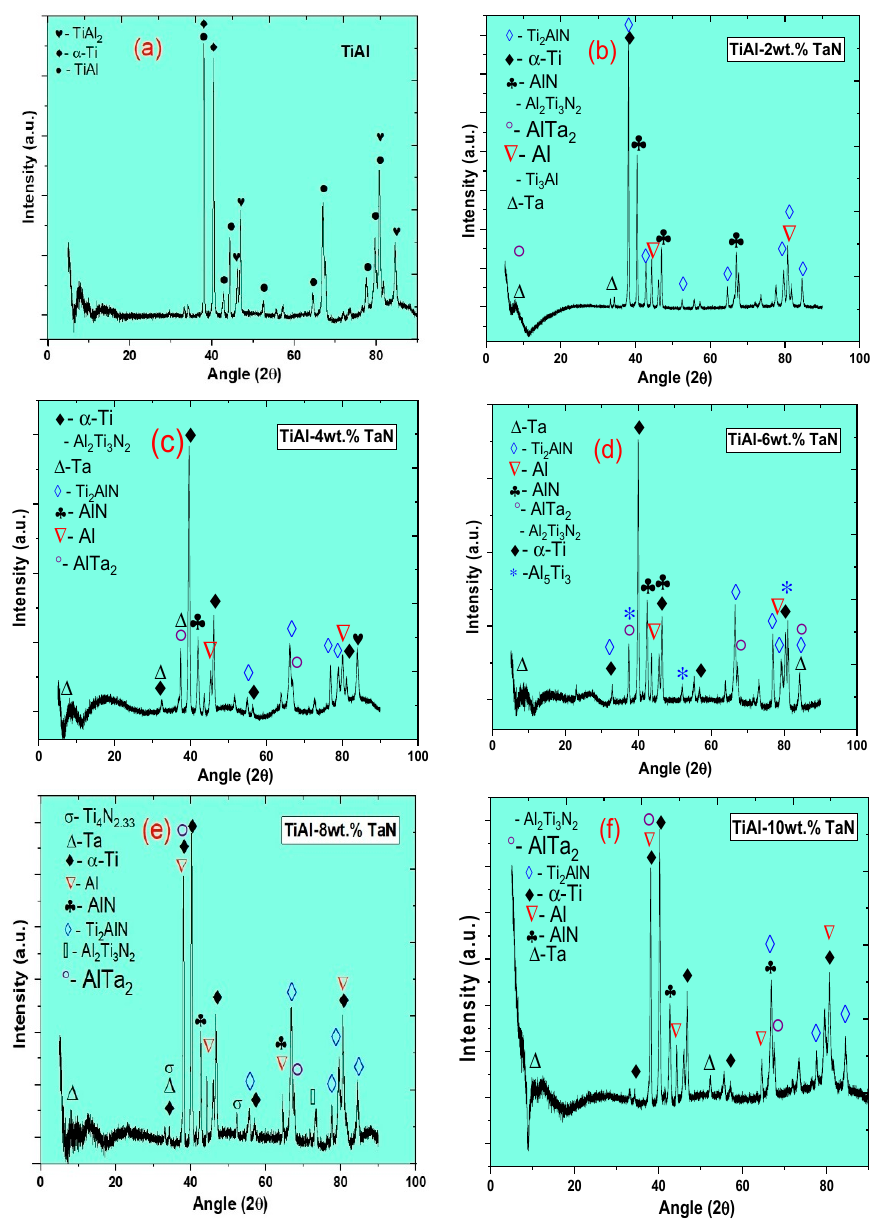
Figure 3. X-ray di ff raction pa tt erns of sintered samples at a sintering temperature of 1050 ° C, pres- Figure 3. X-ray diffraction patterns of sintered samples at a sintering temperature of 1050 ◦ C, pressure sure of 50 MPa, dwell time of 10 min, and heating rate of 100 ° C/min: ( a ) pure TiAl sample, ( b ) of 50 MPa, dwell time of 10 min, and heating rate of 100 ◦ C/min: ( a ) pure TiAl sample, ( b ) TiAl − 2wt.% TaN, ( c ) TiAl − 4wt.% TaN, ( d ) TiAl − 6wt.% TaN, ( e ) TiAl − 8wt.% TaN, and ( f ) TiAl − 10wt.%